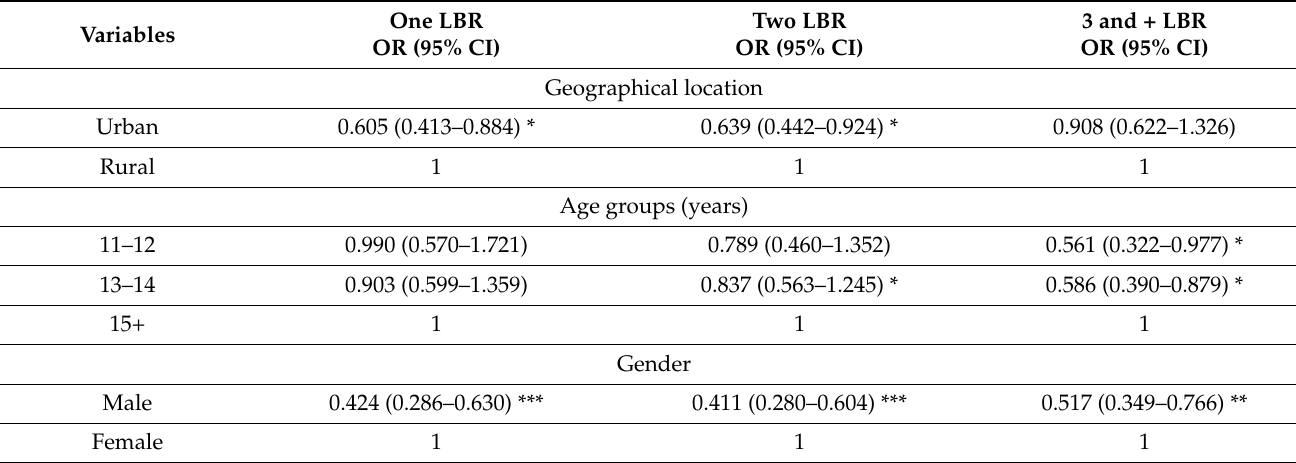
Table 4. Multinomial logistic regression analysis of factors associated with combination of lifestyle behavior risk in Algerian